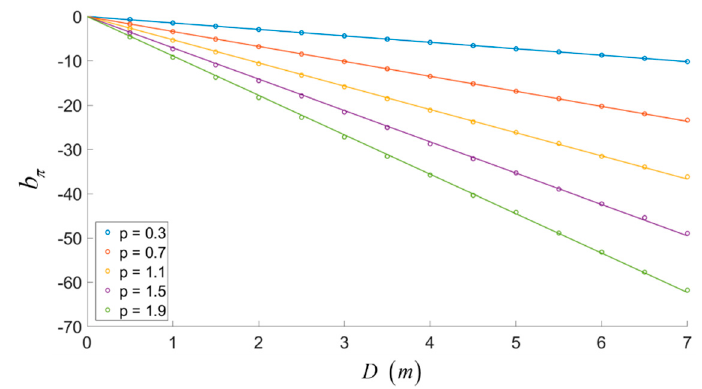
Figure 6. Relationship between b π and D with di ff erent ρ